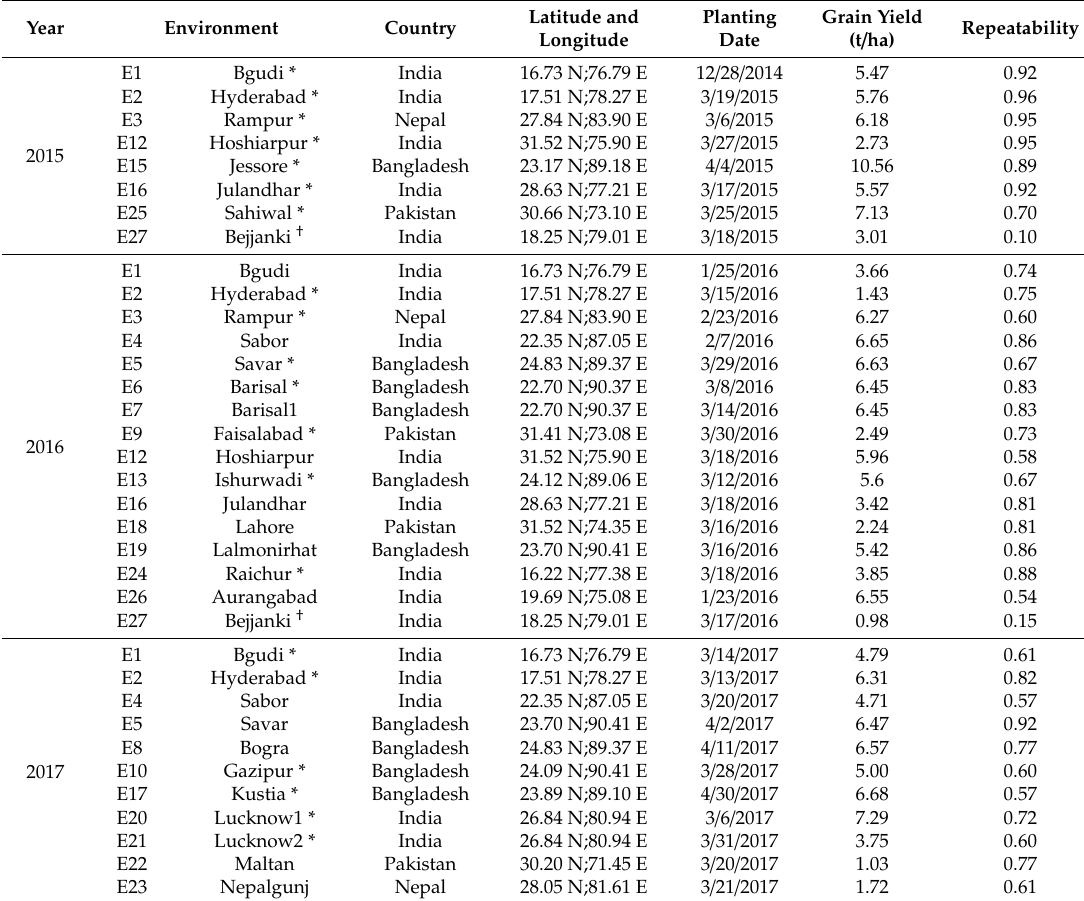
Table 1. Description of the trial locations during post-rainy spring cropping season,